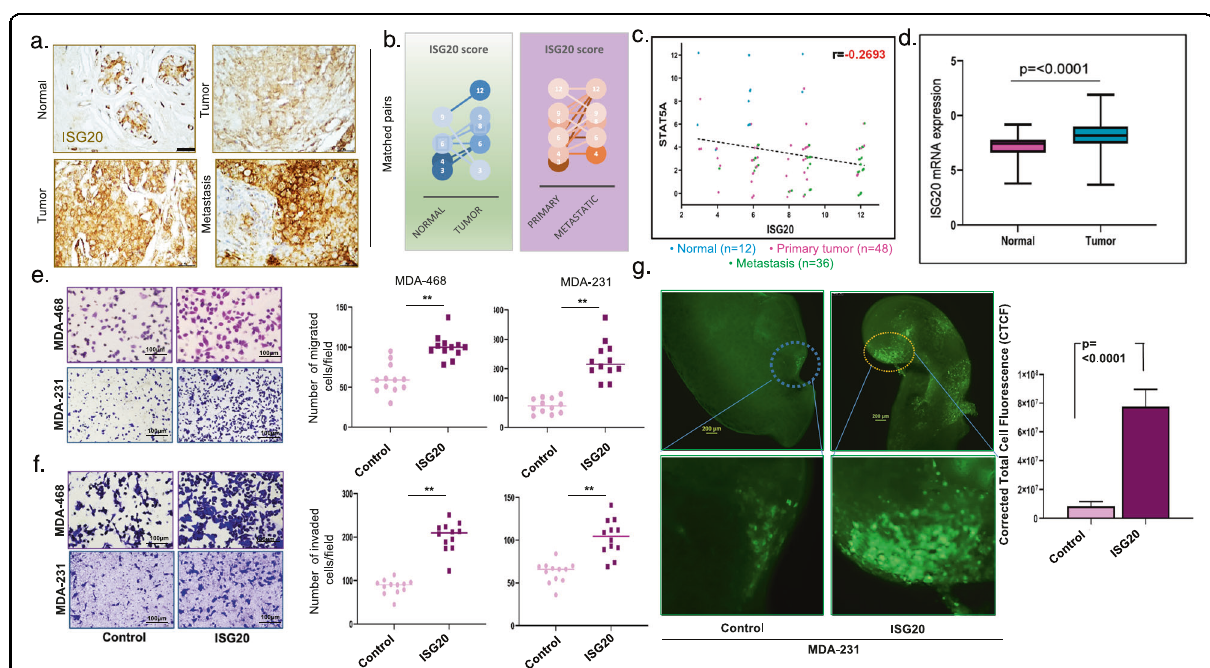
Fig. 6 ISG20 negatively correlates with STAT5A and its expression promotes aggressive metastatic phenotype. a Photomicrographs showing immunohistochemical staining for ISG20 using matched normal breast compared with corresponding primary breast tumor (left panel) and matched primary breast tumor compared with corresponding metastatic LN (right panel). b Immunoscore of ISG20 staining comparing matched human normal breast vs primary breast tumors and matched primary breast tumors vs corresponding metastatic LN. (Average IRS score 6.0 in normal vs 7.2 in tumor ( p = 0.15)) (7.7 in Primary vs 9.5 in metastatic ( p = 0.0002)). c Correlation between STAT5A and ISG20 immunoscores in human breast cancer TMA consisting of normal breast tissues ( n = 12) primary breast tumors ( n = 48) and metastatic LN ( n = 36), graph represents a signi fi cant negative correlation between ISG20 and STAT5A score (r = 0.27) ( p = 0.008). d ISG20 mRNA expression from TCGA data (RNA-seq) for breast cancer- normal breast tissues and breast tumor tissues are compared. ISG20 expression is signi fi cantly higher in breast cancer compared to normal breast tissue ( p ≤ 0.0001). e Representative images of transmembrane migration for control or MDA-MB-468 and MDA-MB-231 cells overexpressing ISG20. Graphs represent signi fi cantly higher migrated cells/ fi eld in ISG20 expressing MDA-MB-468 ( p = 0.0003) and MDA-MB-231 ( p ≤ 0.0001). f Representative images for control or ISG20 MDA-MB-468 and MDA-MB-231 cells Invading through Matrigel invasion chamber. Graphs represent signi fi cantly higher invaded cells/ fi eld in ISG20 MDA-MB-468 ( p ≤ 0.0001) and MDA-MB-231 ( p ≤ 0.0001). g Images from fl uorescence labelled MDA- MB-231 control or ISG20 overexpressing cells in PUMA assay. Nude mice were injected in the lateral tail (1 × 10 5 ). Agar perfused lung slices were cultured on Surgifoam for 32 days. Metastatic burden was quanti fi ed as corrected total cell fl uorescence (CTCF). MDA-MB-231 cells overexpressing ISG20 show a higher metastatic burden than the control cells ( p ≤